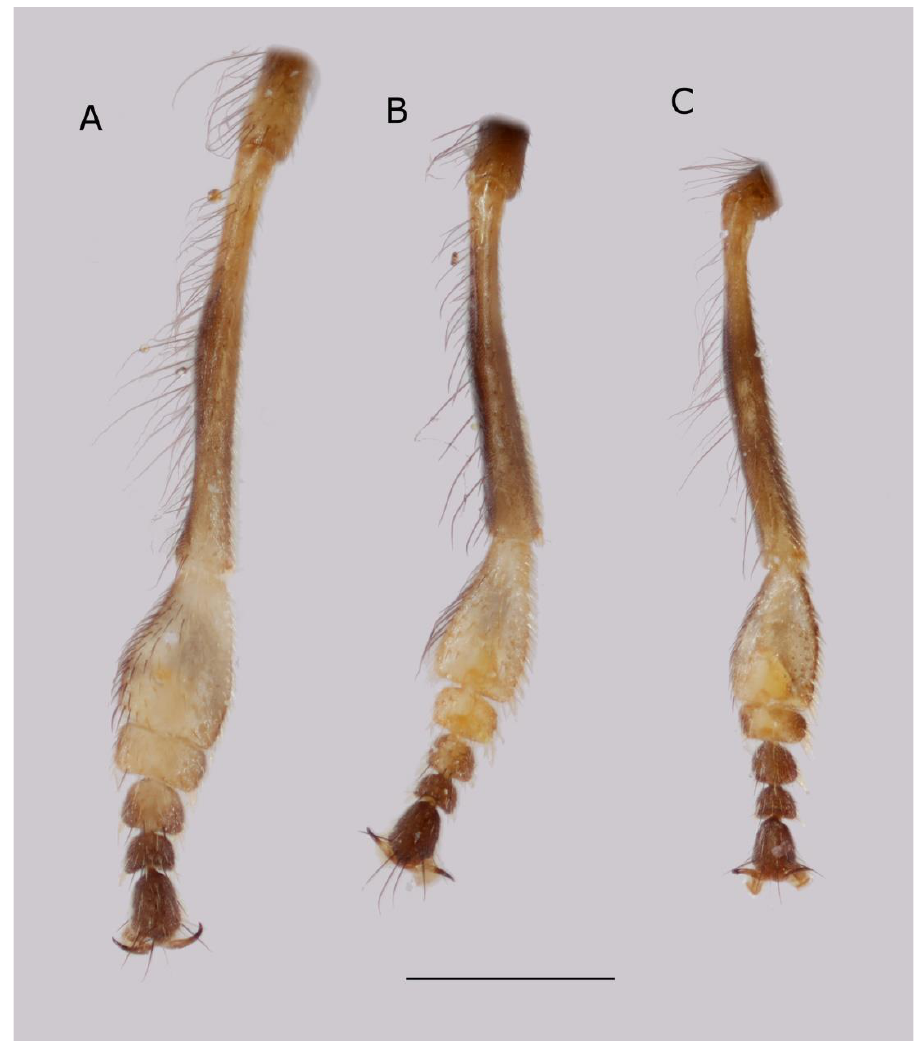
Figure 8. Adult male proleg, dorsal view: (A) Platycheirus groenlandicus , Ammarnäs, Sweden; (B) Platycheirus subordinatus , Seitajaure, Sweden; (C) Platycheirus torei , Seitajaure, Sweden. Scale bar 0.5